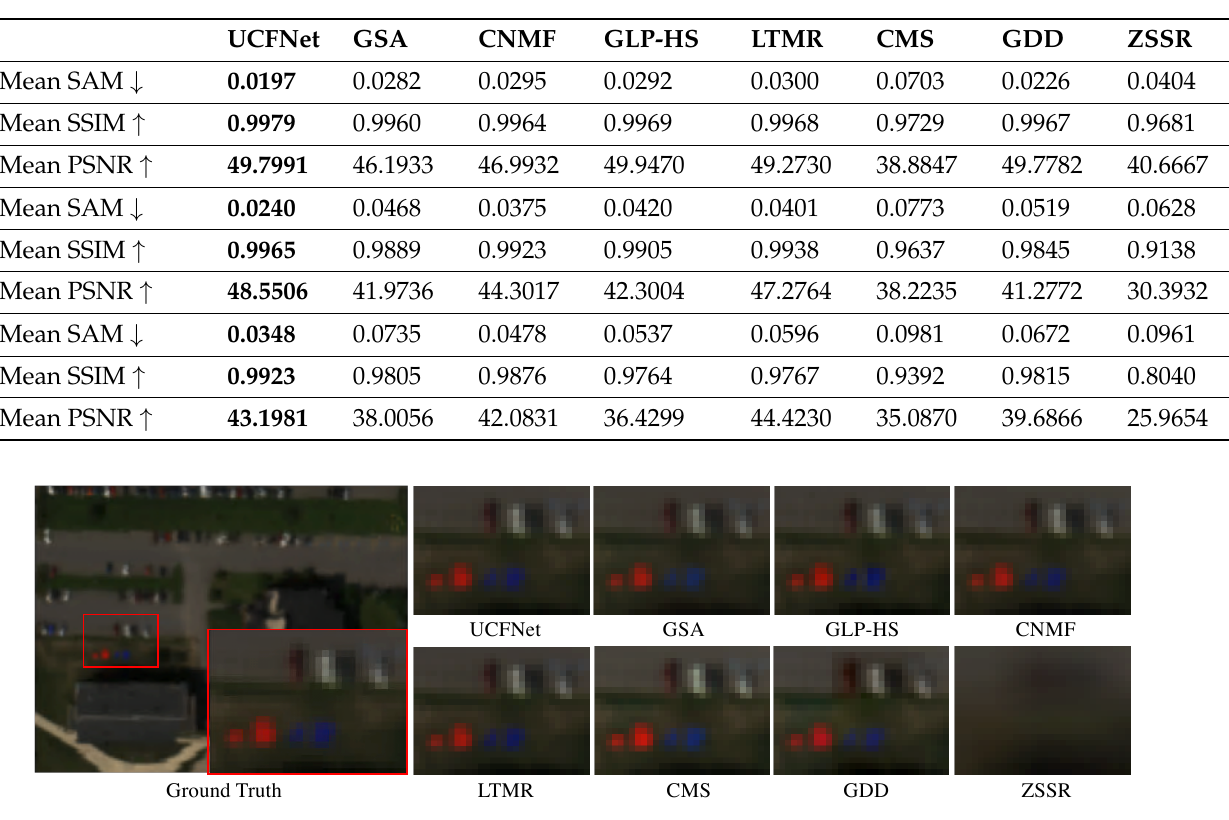
Figure 9. Reconstructed composite images of the SHARE-2010 dataset (R: 697 nm, G: 576 nm, B: 492 nm) with a up-scale factor of